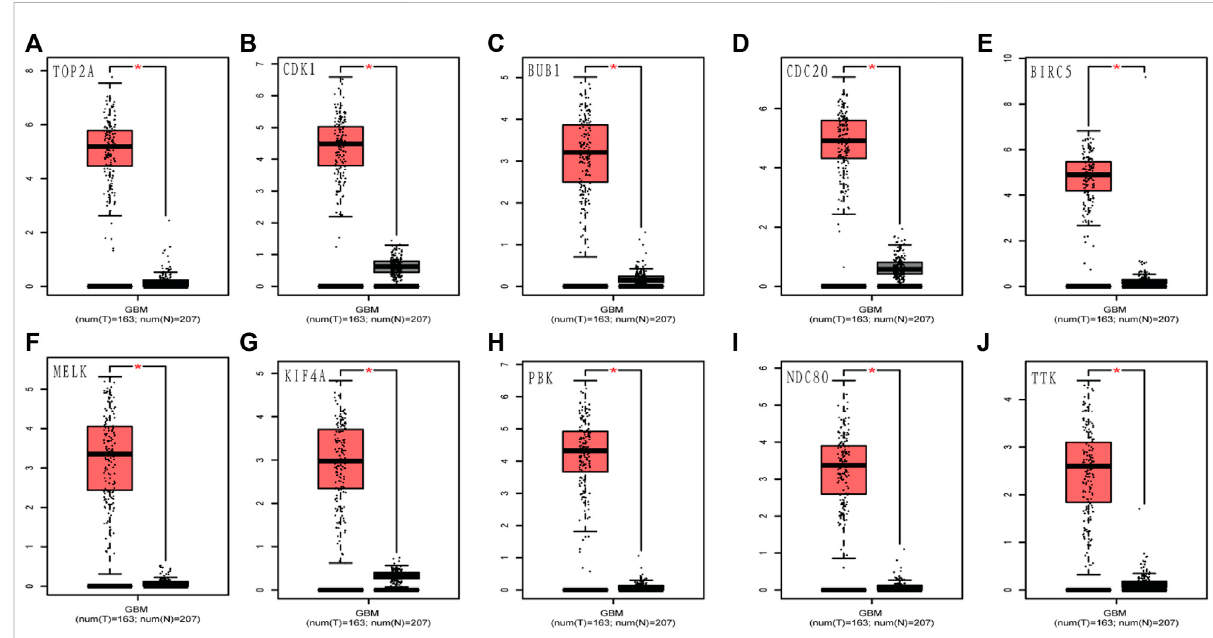
FIGURE 5 Validation of the 10 hub gene expression levels between normal brain and GBM samples from TCGA and GTEx data in GEPIA. All of the 10 hub genes were found to be upregulated. (A) TOP2A , (B) CDK1 , (C) BUB1 , (D) CDC20 , (E) BIRC5 , (F) MELK , (G) KIF4A , (H) PBK , (I) NDC80 , and (J) TTK . TCGA: The Cancer Genome Atlas. * p < 0.05.